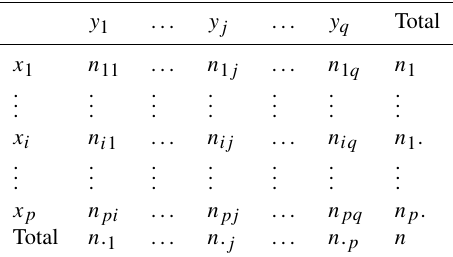
Table 9. Contingency table of the observed values of the X and Y